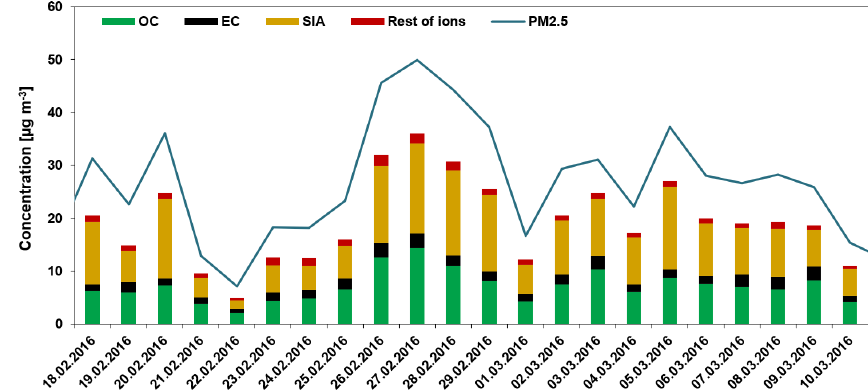
Figure 2. Time series of daily concentrations (micrograms per cubic meter; hereafter µgm − 3 ) of PM 2 . 5 (line) and its main components (bars) in Warsaw in the sampling period from 18 February to 10 March 2016. The rest of the ions indicate the sum of concentrations of the K + , Cl − , Na + , Mg 2 + , and Ca 2 + ions. Table 1. Descriptive statistics for the hourly concentrations (nanograms per cubic meter; hereafter ngm − 3 ) of the elements measured in the fine and coarse fractions. Minimum concentrations below the detection limit are indicated by an